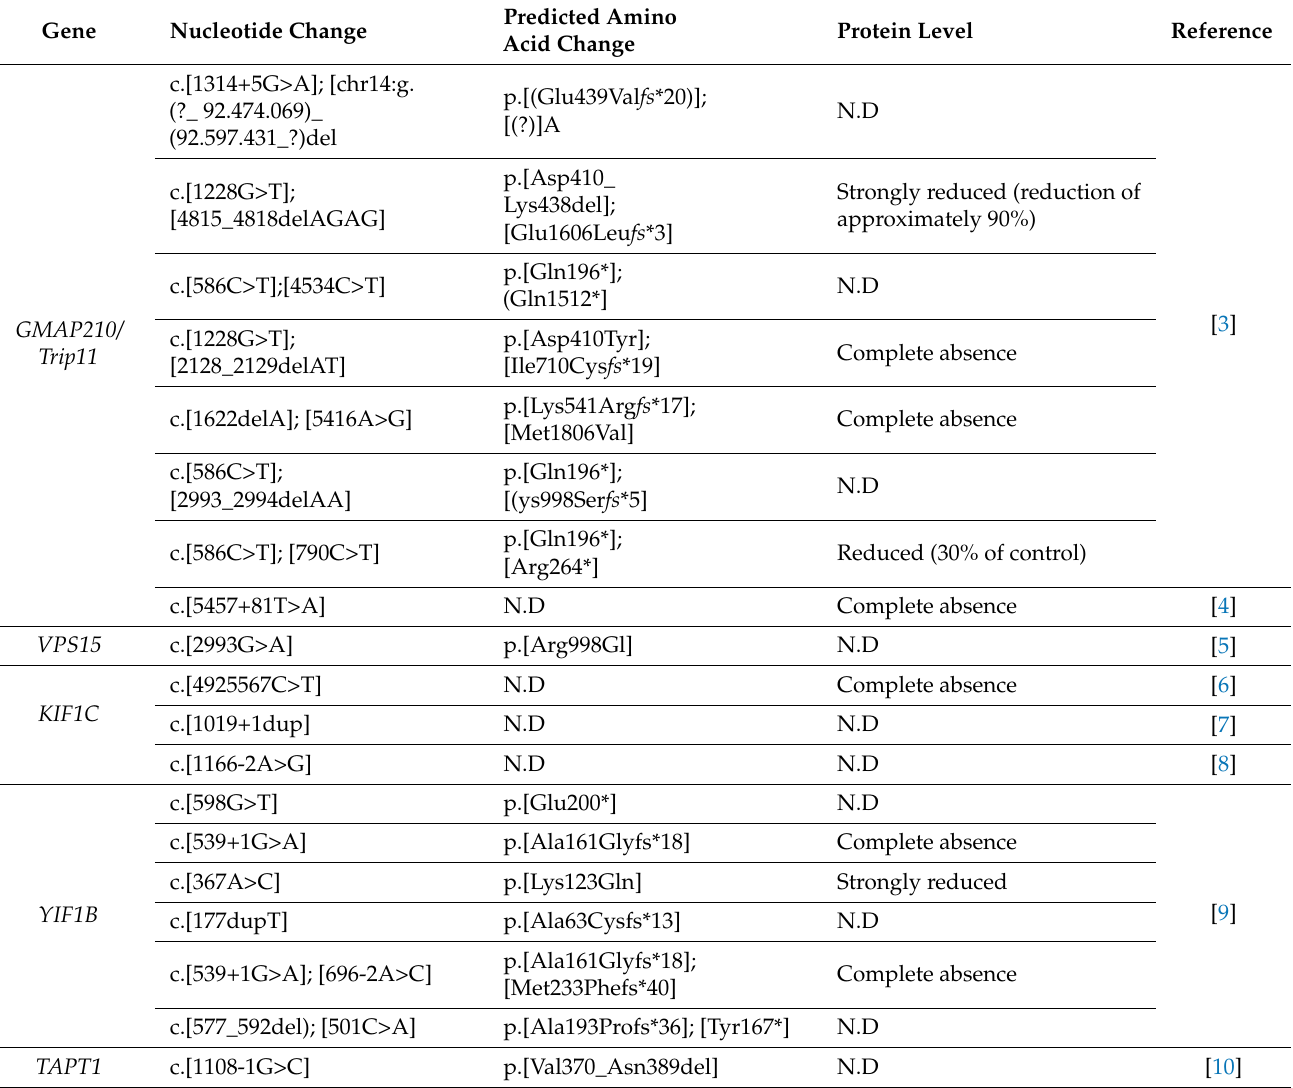
Table 1. List of mutated genes coding for GA and GA-associated proteins identified in patients presenting some of the clinical features of ciliopathies. *, stop codon.